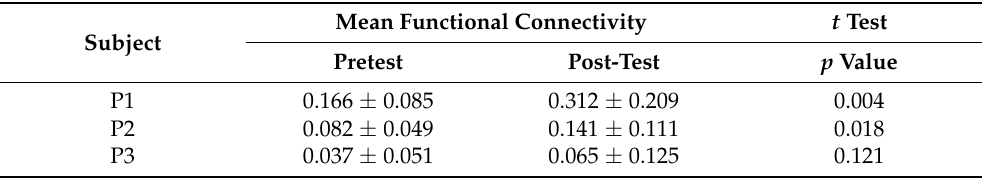
Table 4. Mean functional connectivity values (considering only positive correlations) over the AAL motor-related regions (listed in Table 2) and standard deviation, at pretest and